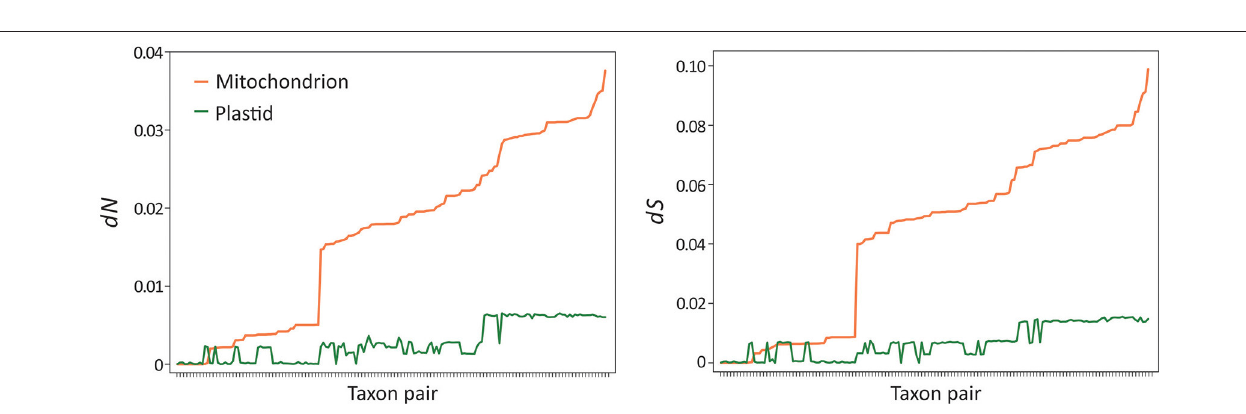
FIGURE 6 | Elevated nucleotide substitution rates in banana mitogenomes. Paired t -tests indicate that both non-synonymous ( dN , P = 1.19 × 10 − 42 ) and synonymous ( dS , P = 2.77 × 10 − 42 ) rates are significantly elevated in mitochondria compared to plastids after the Bonferroni correction. Taxon pairs were sorted based on mitochondrial rates from the slowest to the